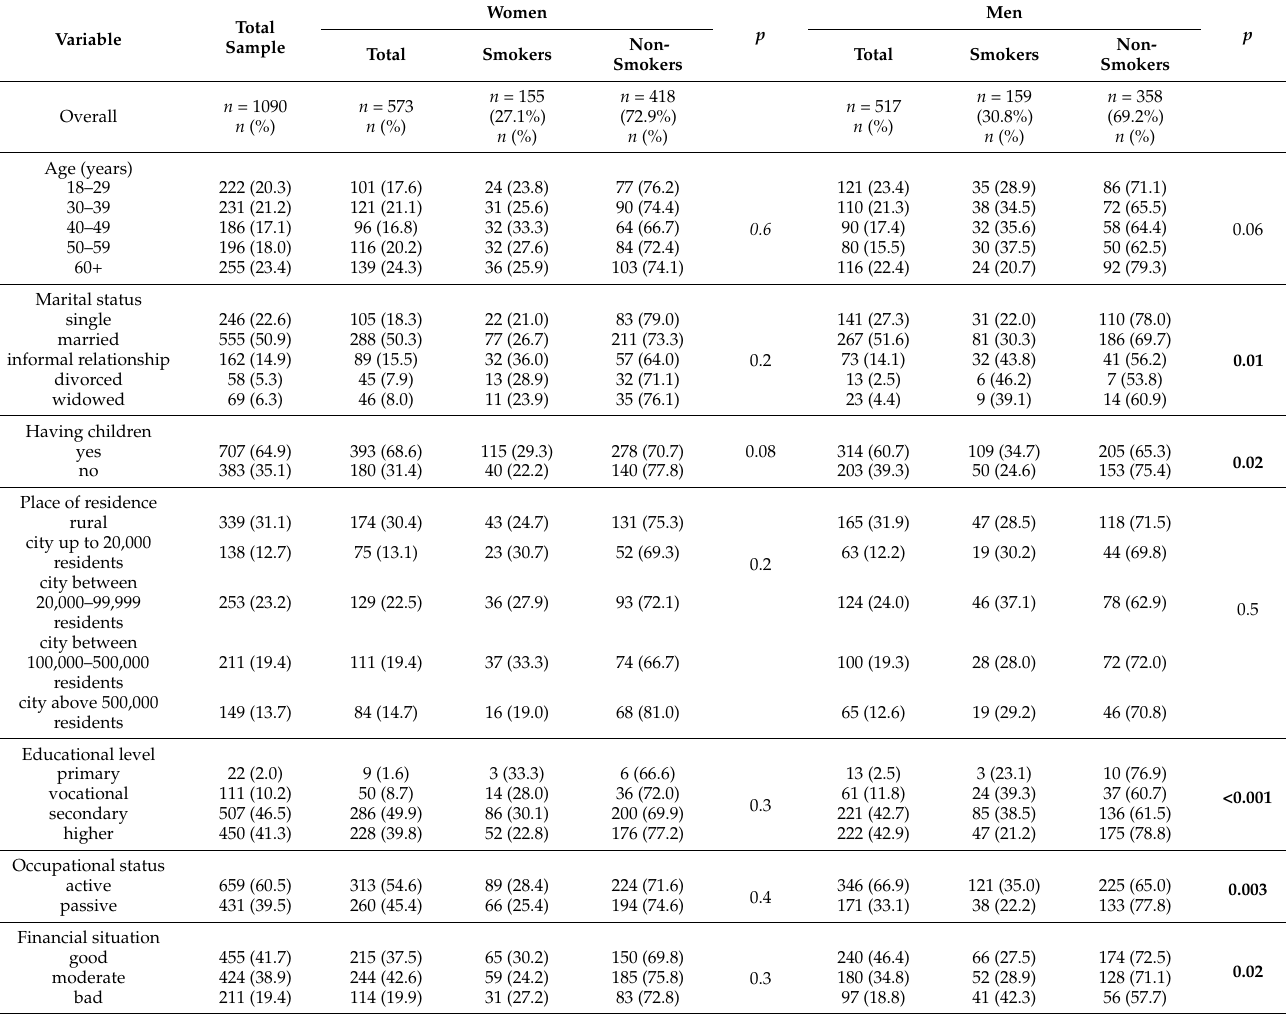
Table 1. Characteristics of the study population by smoking status (n =